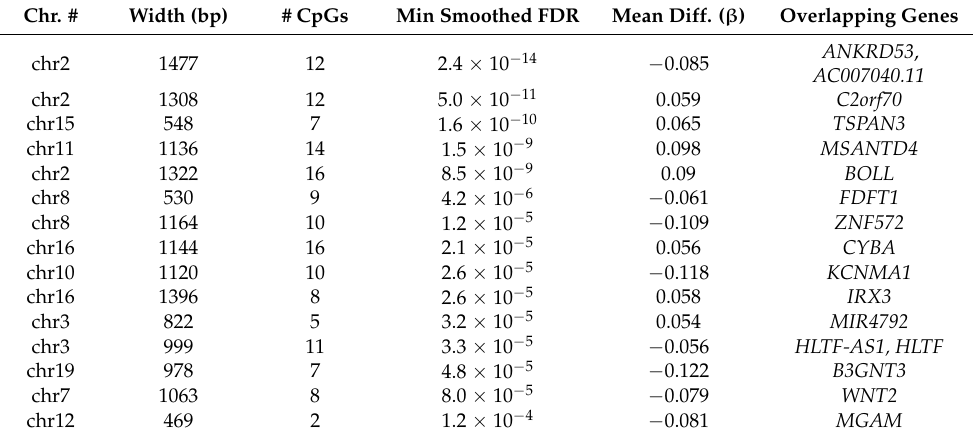
Table 2. Top 15 differentially methylated regions (DMRs) annotated in opioid-exposed samples by minimum smoothed FDR (| ∆ β | ≥ 0.05).